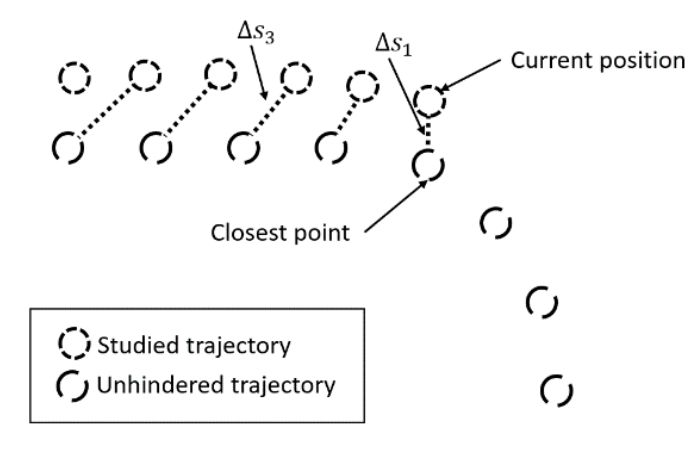
Figure 3 The calculation process for the similarity between two trajectories at a specific point in time